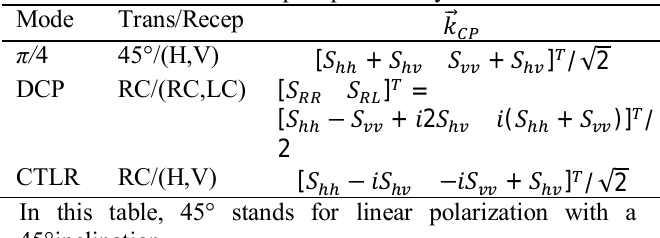
Table 3: Compact polarimetry modes Mode